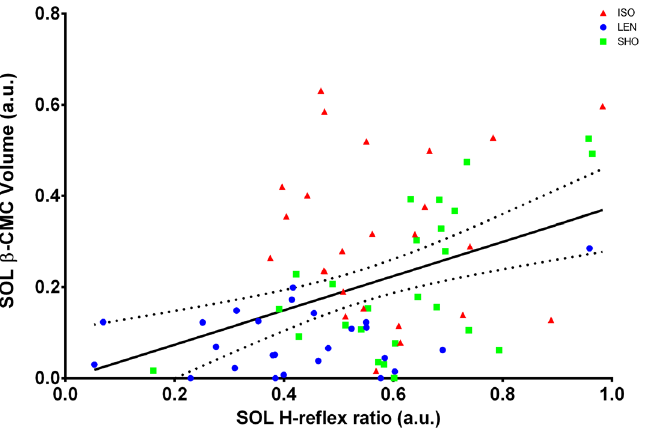
Figure 3. Correlation between beta-band CMC and normalized H-reflex in the SOL. The relationship between beta-band CMC (SOL β-CMC Volume) and the normalized H-reflex (SOL H-reflex ratio) have been calculated in the SOL, across all participants. A significant correlation was observed between SOL β-CMC Volume and SOL H-reflex ratio (r = 0.421, p < 0.001). Data obtained during lengthening contractions (LEN) are shown in blue, during isometric contractions (ISO) in red and during shortening ones (SHO) in green. The solid line shows the estimated regression line, and the dashed lines represent its 95%